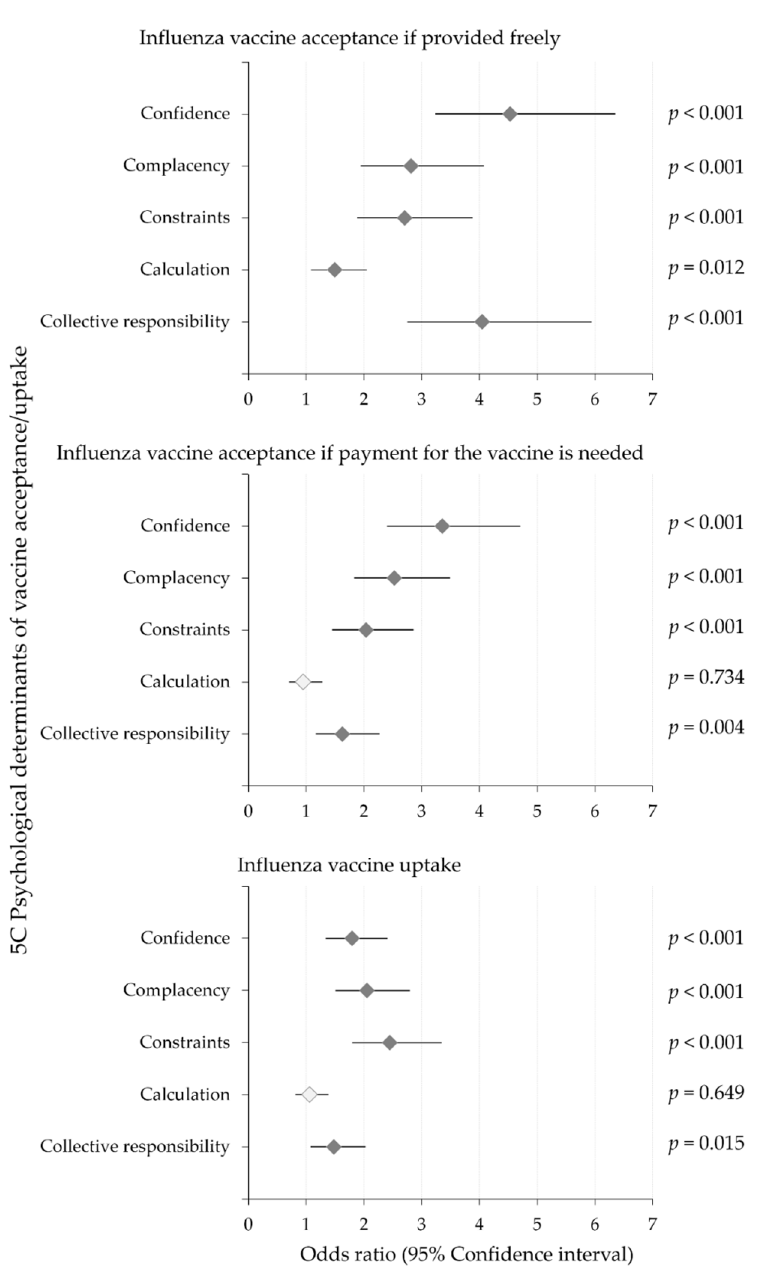
Figure 3. Multinomial regression analysis of the five psychological determinants (subscales) for influenza vaccine hesitancy and their association with influenza vaccine hesitancy (intent to receive influenza vaccination, with no/maybe responses). The mean odds ratios are represented by the gray diamond symbols, whereas the 95% confidence intervals are indicated by black bars. Age ( p = 0.002, with a higher rate among participants older than 38 years) and monthly income ( p = 0.005, with a higher rate among participants with monthly income JOD ≥ 1000) were the only covariates that were associated with willingness to pay for influenza vaccination, whereas sex ( p = 0.170), education ( p = 0.143) and occupational category ( p = 0.523) did not show such a